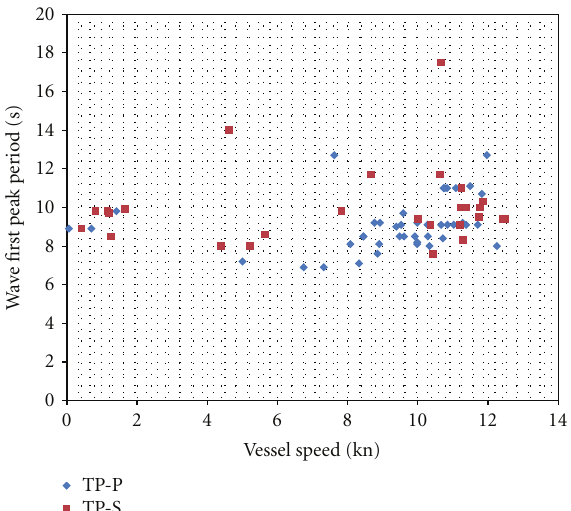
Figure 30: Wave first peak period versus wave significant spectral height during the events—blue for port and red for